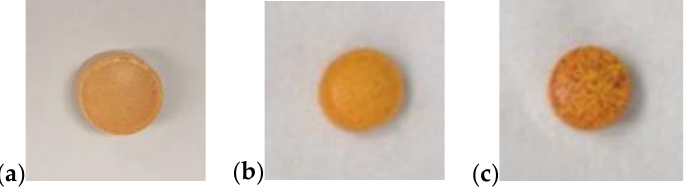
Figure 4. PCBAE prodrug tablets: ( a ) T0 (initial); ( b ) one week at standard storage conditions, i.e., 25 °C and 57% RH; ( c ) one week at accelerated storage conditions, i.e., 40 °C and 75% RH.